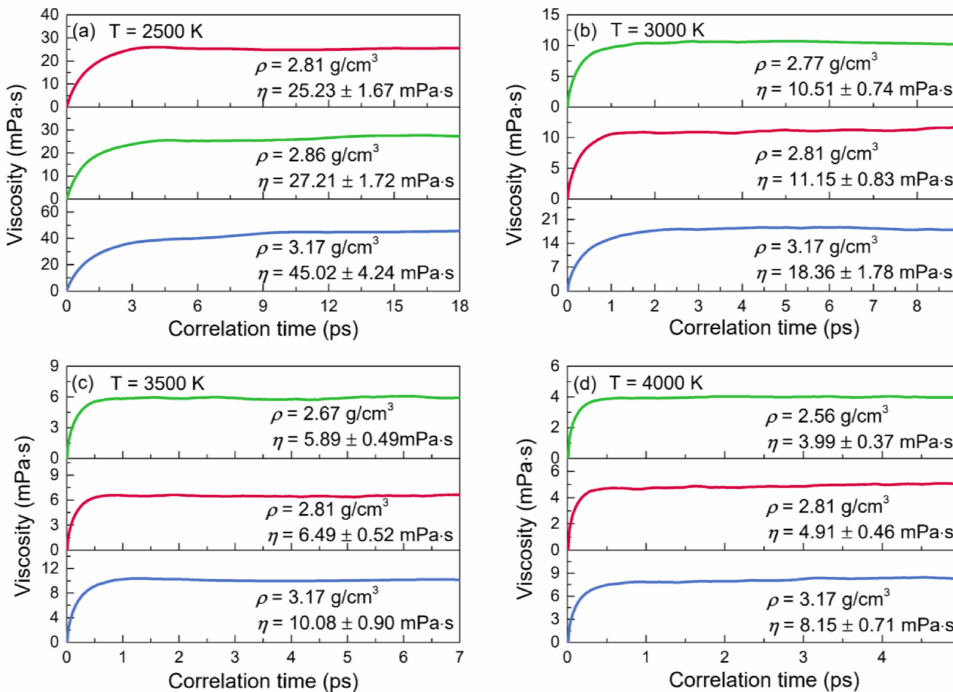
Figure 10. Viscosities ( η ) for the configurations of liquid alumina with three different densities at ( a ) 2500 K, ( b ) 3000 K, ( c ) 3500 K, and ( d ) 4000 K,